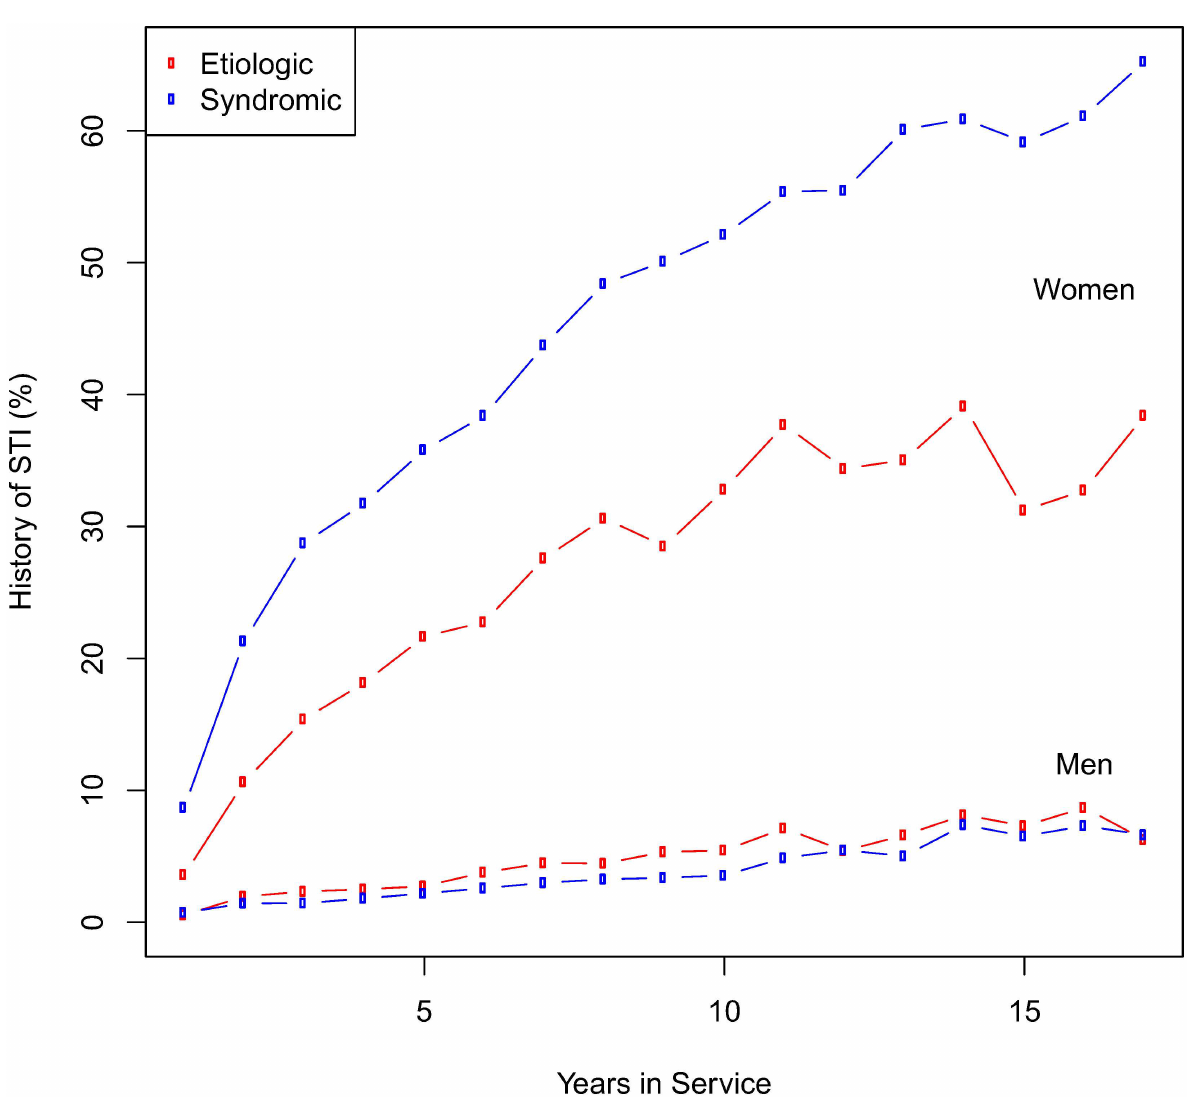
Fig 1. Percentage of individuals with a sexually transmitted infection by year of service.